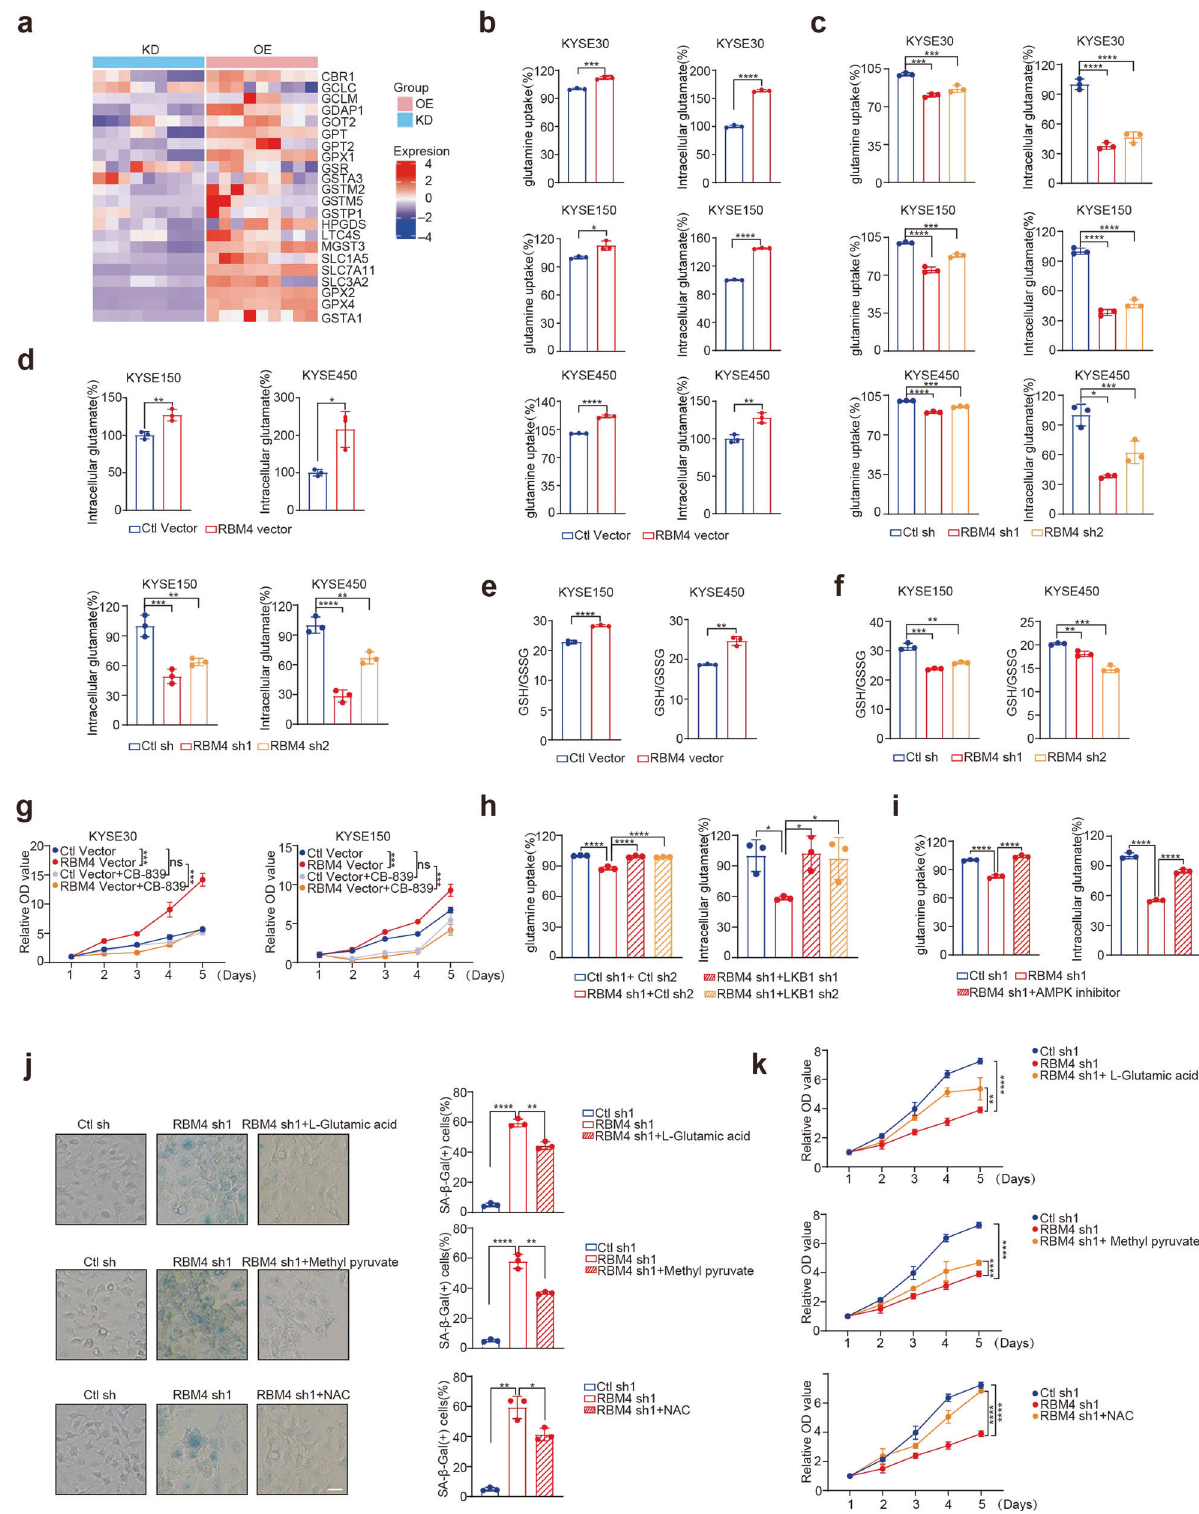
also elevated the activity of senescence marker, SA- β -gal, in colorectal and liver cancer cell lines (Supplementary Fig. 6j), but not increased p27 expression (Supplementary Fig. 6i), suggesting the underlying mechanism is different from that in ESCC cells. We proposed that these fi ndings might result from tissue speci fi city Signal Transduction and Targeted Therapy (2023)